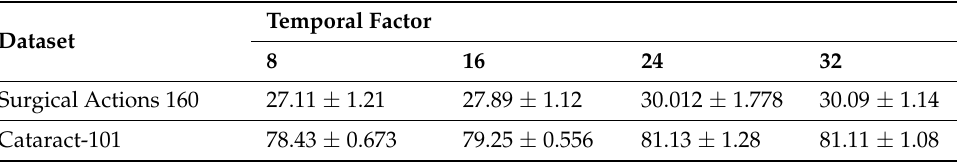
Table 2. mAP % (mean ± std.) when training under different temporal lengths of video sequence on two datasets under the CB-SVR